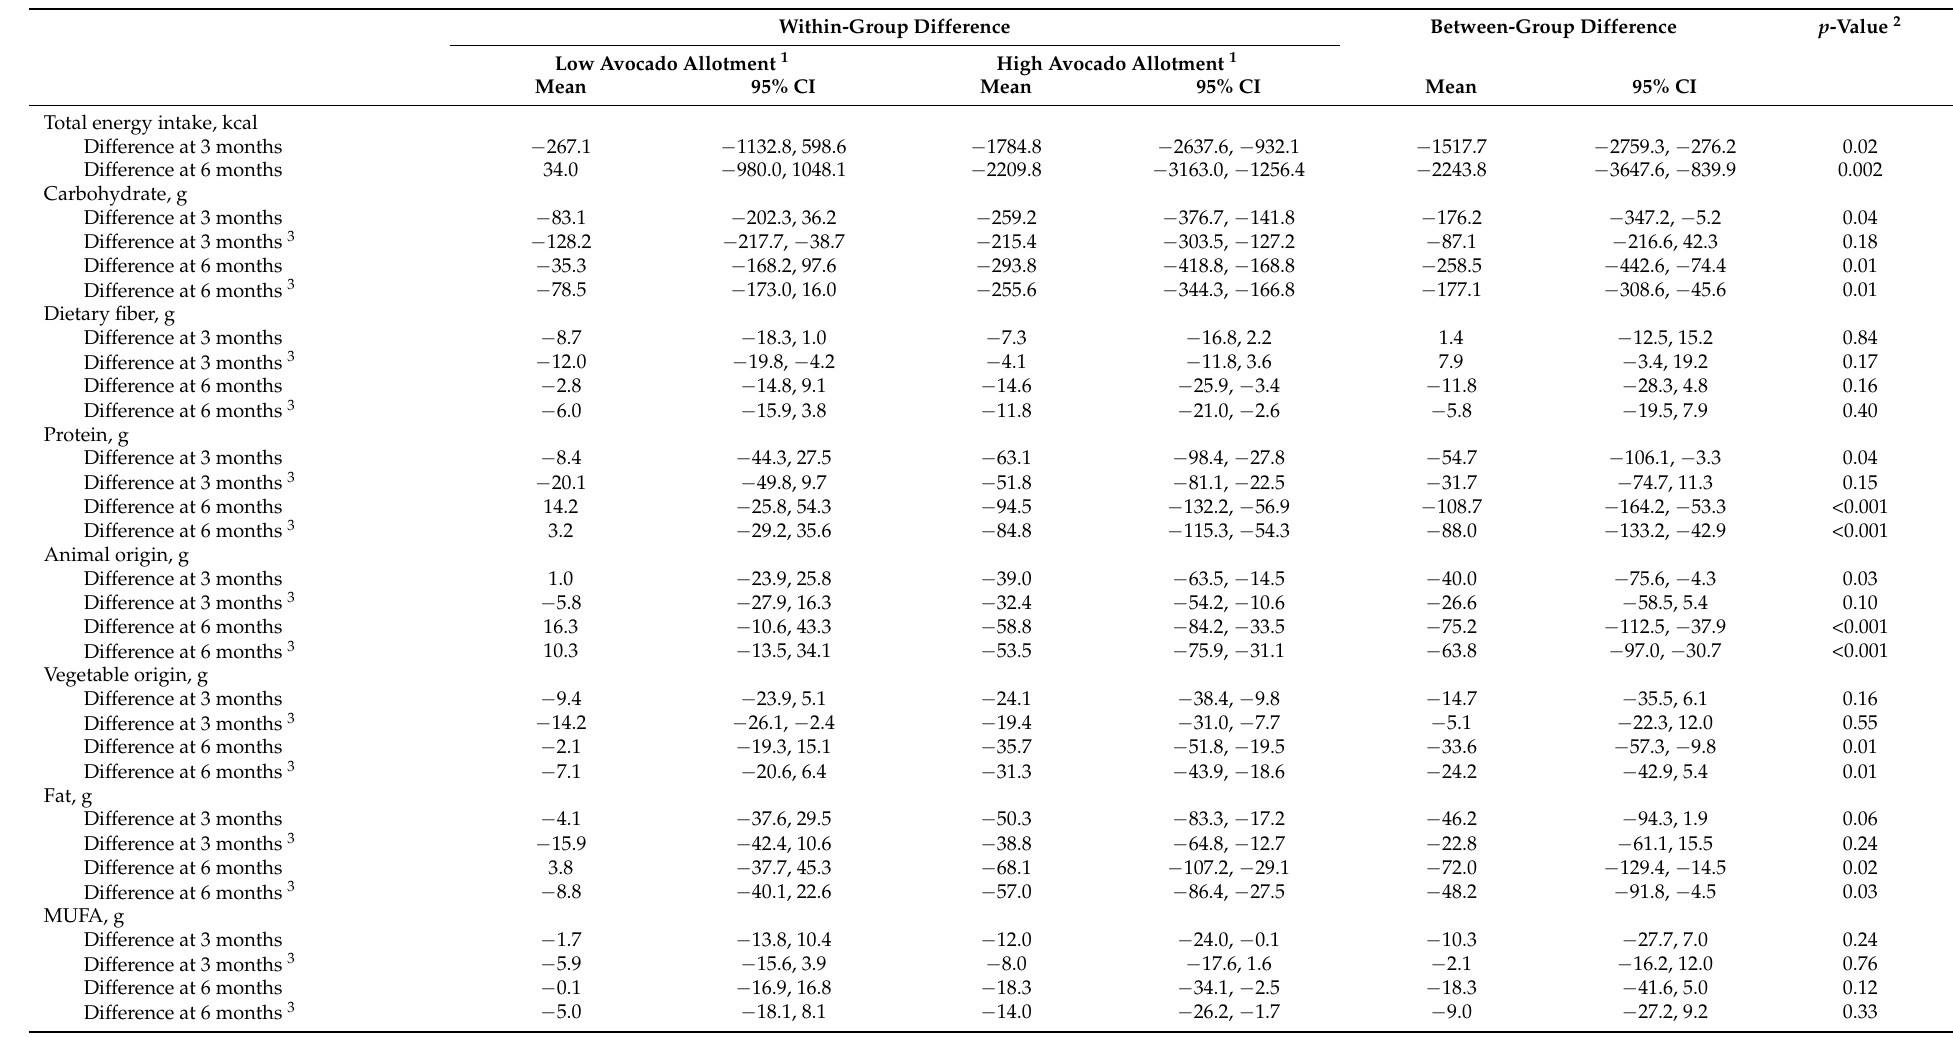
Table 7. Changes in family nutritional status per protocol adherence analysis in the Effects of Avocado Intake on the Nutritional Status of Families Trial. Within-Group Difference Between-Group Difference p -Value 2 Low Avocado Allotment 1 High Avocado Allotment